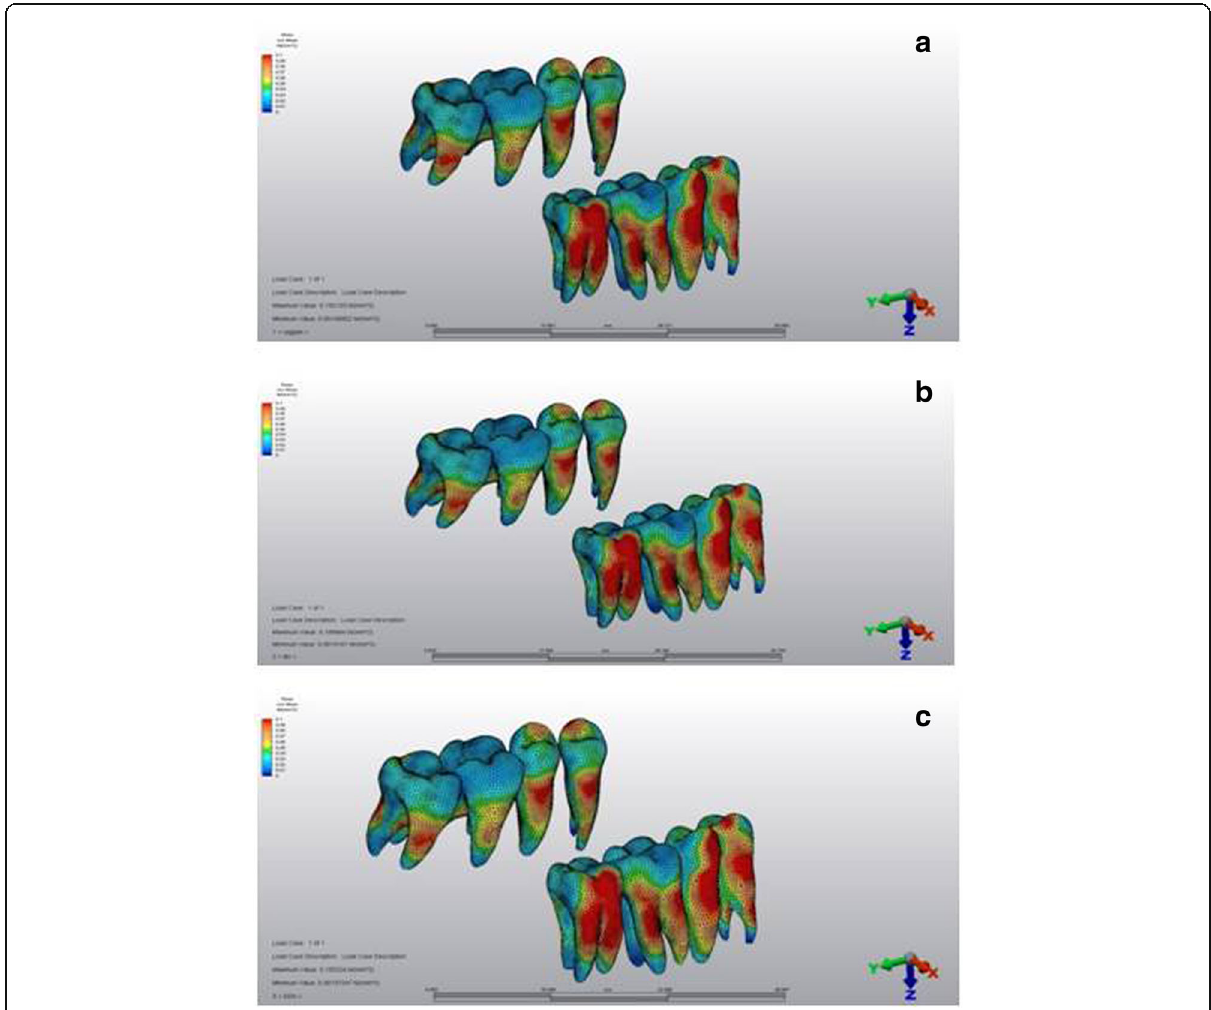
Fig. 8 Stress distributions over the dental structures a first, b second, and c third scenarios